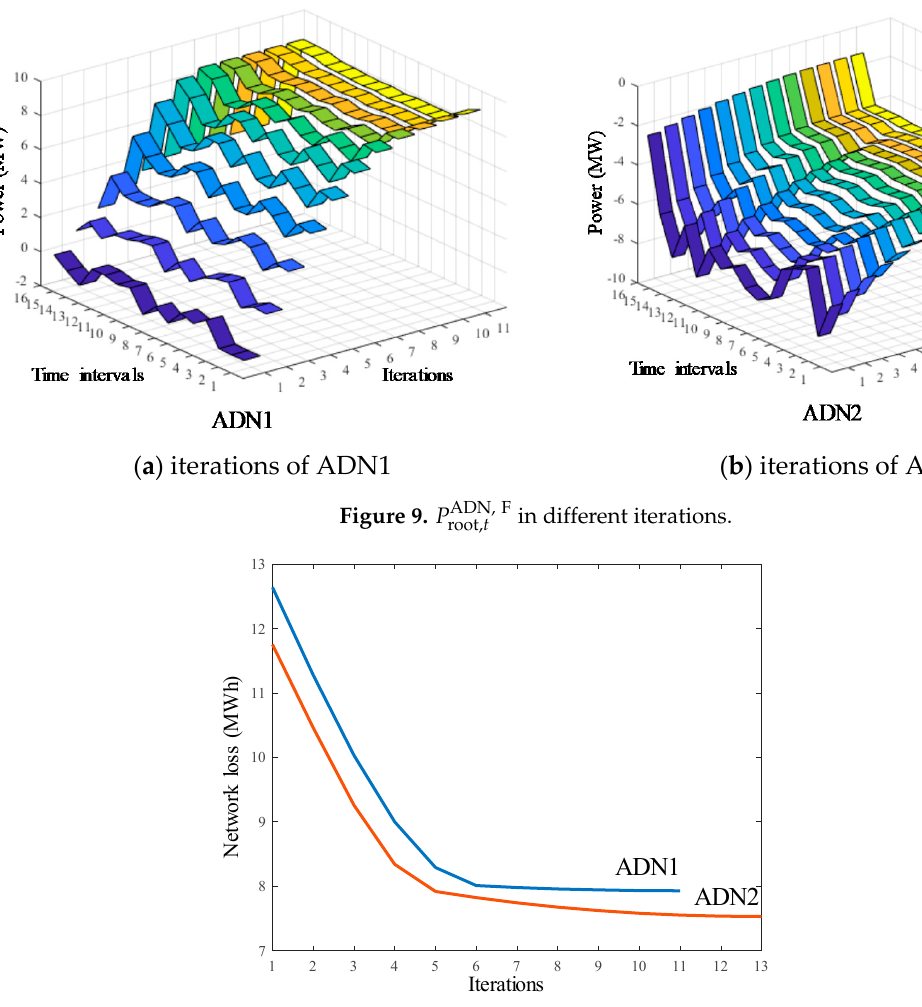
Figure 10. Network losses in different iterations. Table 2. Comparison of optimizations under different price ranges.